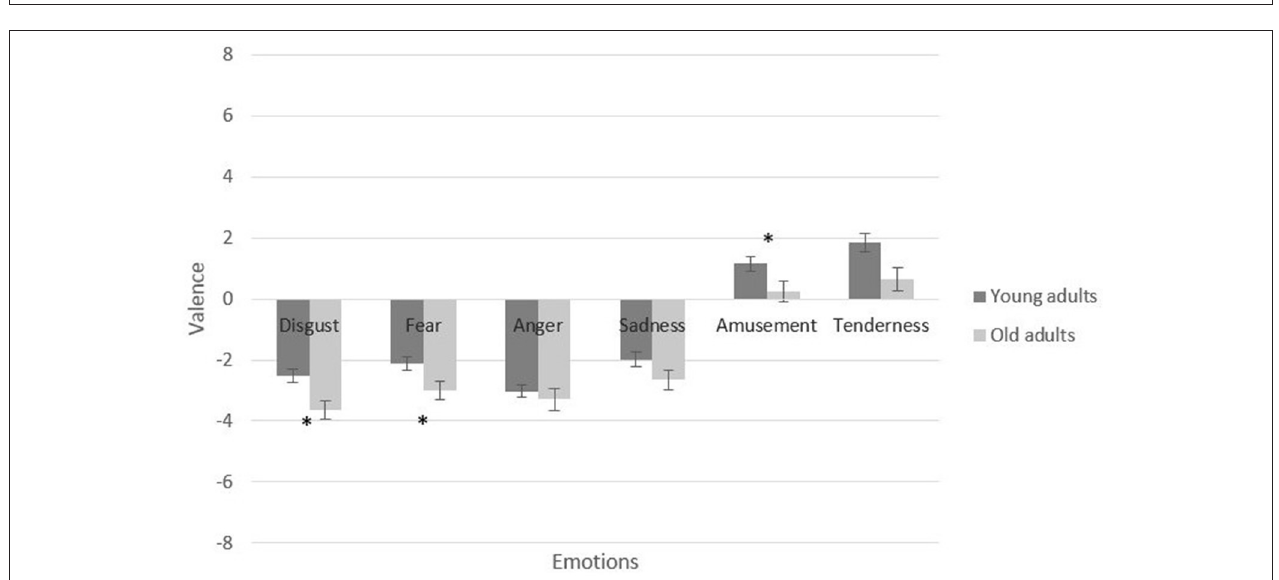
FIGURE 4 | Self-reported valence of participants by film condition and age group. Participant-level means of differences between targets scores and baseline categories. Error bars depict standard error (SE) values. * p < 0.05.